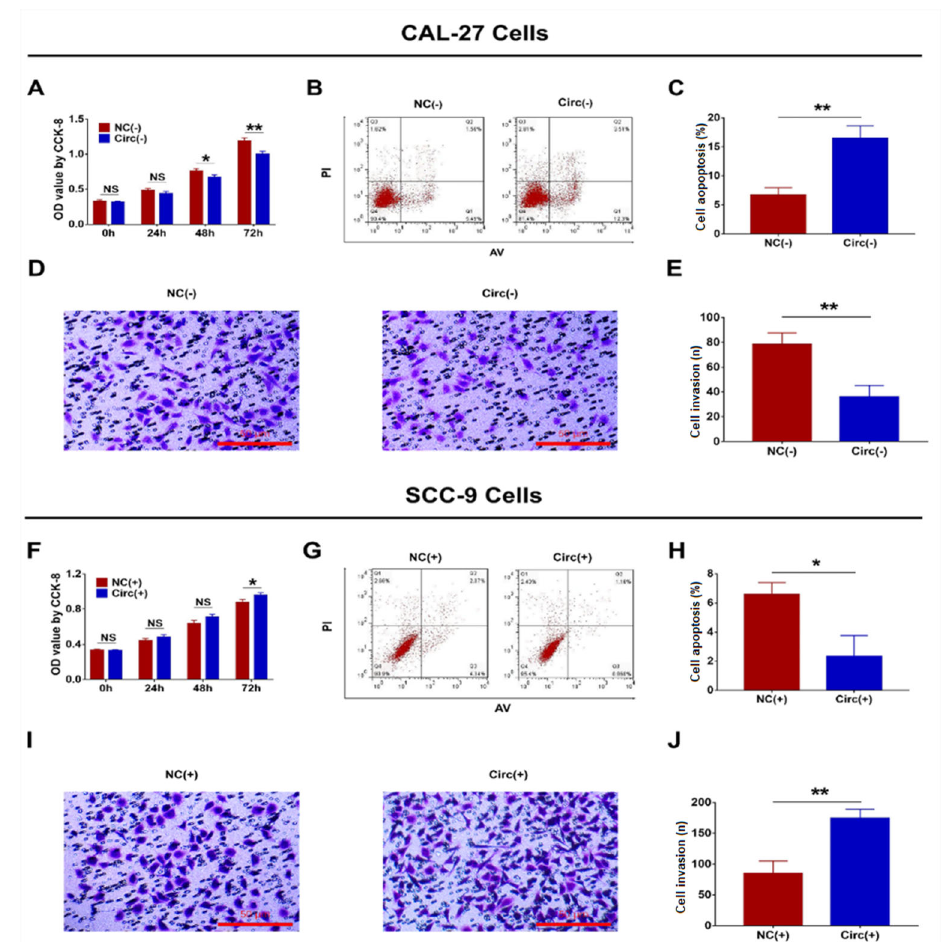
Figure 3. Comparison of cell proliferation ( A ), apoptosis ( B and C ), and invasion ( D and E ) between the Circ( – ) group and the NC( – ) group (scale bar: 50 m m). Comparison of cell proliferation ( F ), apoptosis ( G and H ), and invasion ( I and J ) between the Circ( + ) group and the NC( + ) group (scale bar: 50 m m). Hsa_circ_0002162 knock-down plasmid and circRNA control knock-down plasmid were transfected into CAL-27 cells and then divided into Circ( – ) cells and NC( – ) cells, accordingly. Hsa_circ_0002162 overexpression plasmid